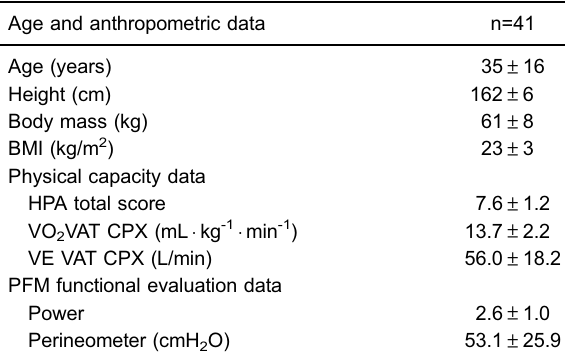
Table 1. Demographic and anthropometric characteristics, and data related to the pelvic fl oor muscles function and the physical capacity of the studied sample.